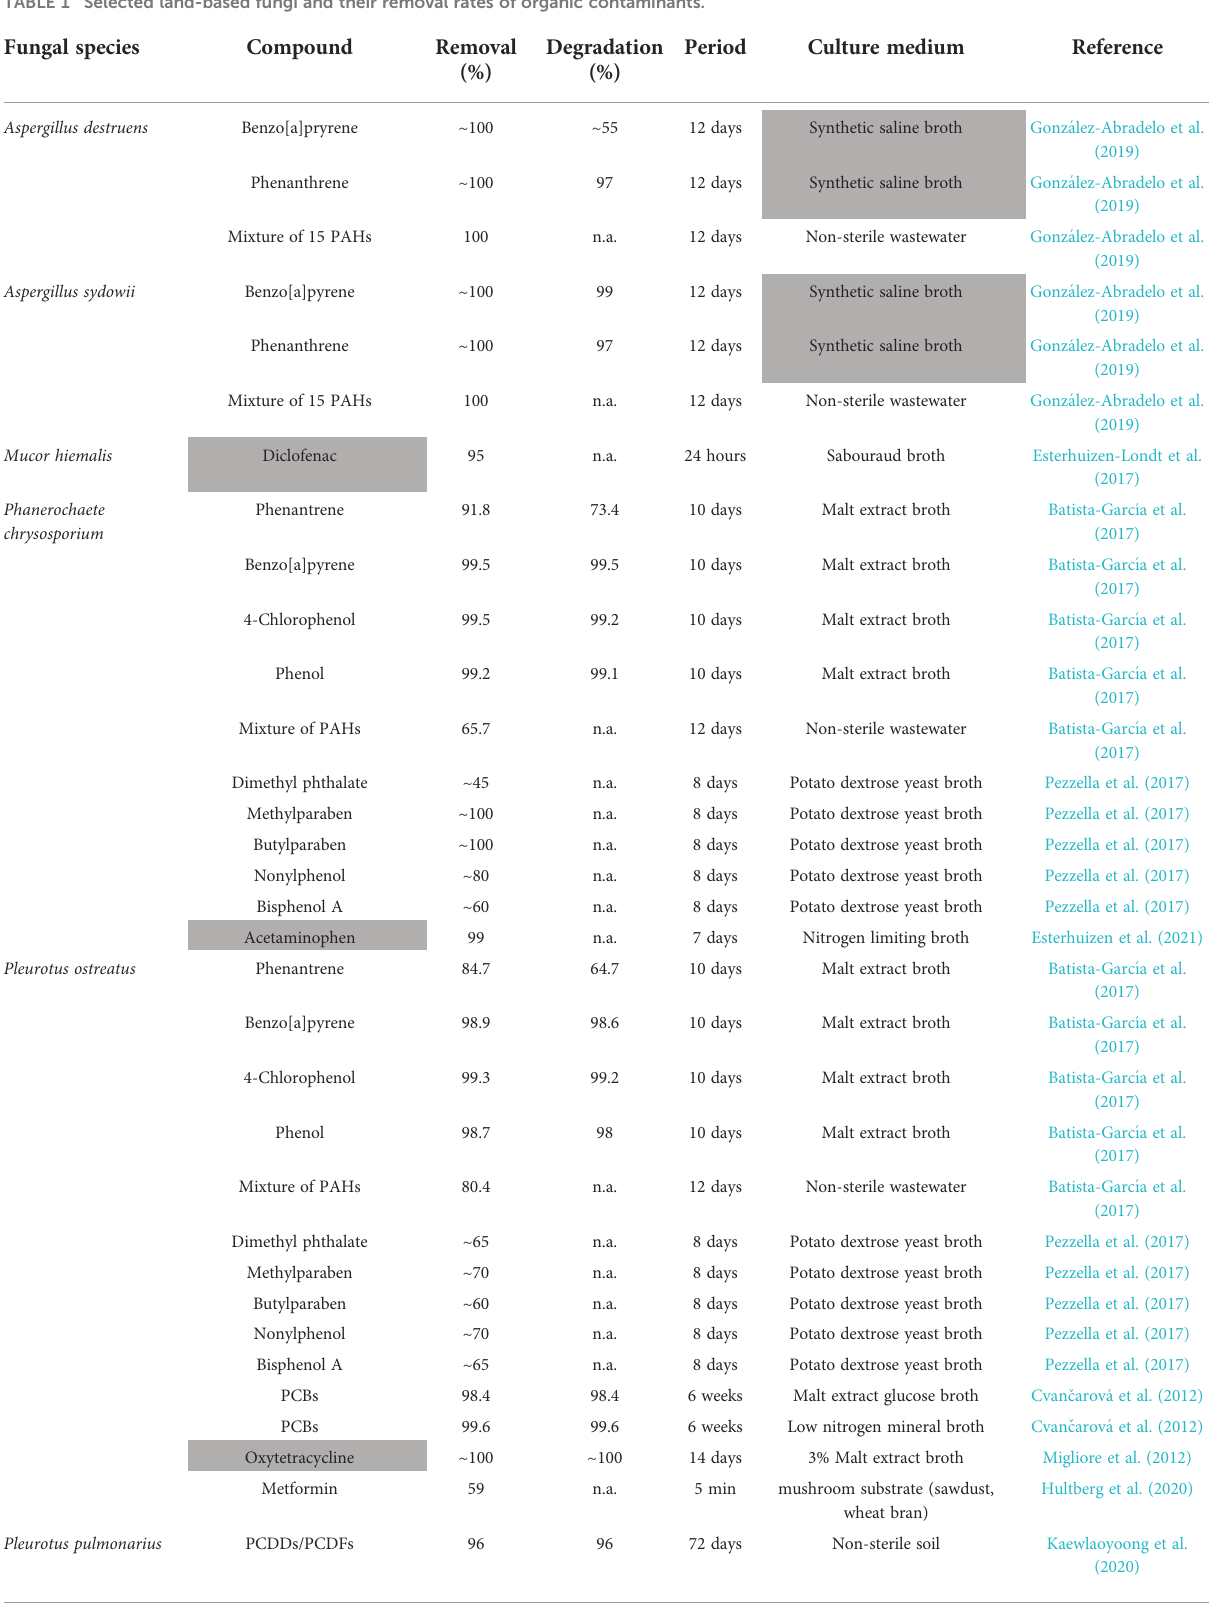
TABLE 1 Selected land-based fungi and their removal rates of organic contaminants. Fungal species Compound Removal